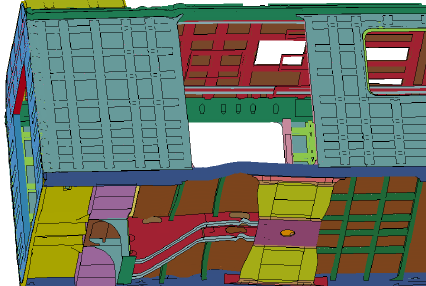
Figure 10. Deformation at end of collision